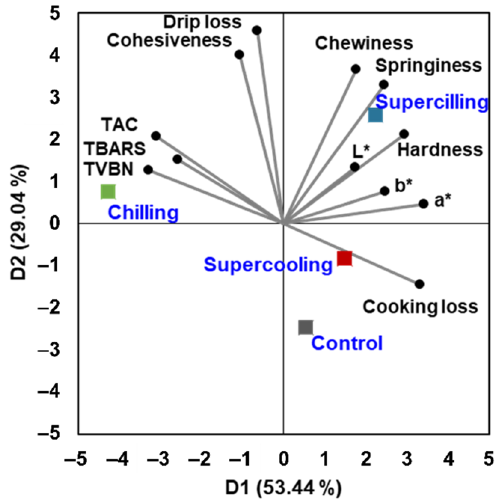
Figure 3. Principal component analysis of dependent variables and preservation treatments of beef loin.